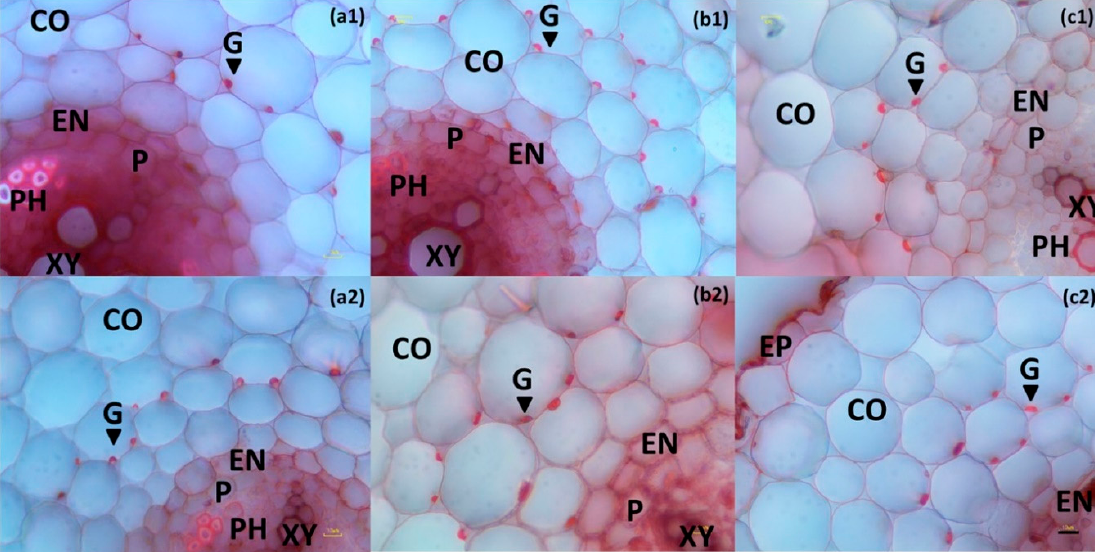
Figure 3. Freehand cross sections of first-order lateral roots under well-irrigated conditions ( a1 , b1 and c1 ) and drought stress conditions ( a2 , b2 and c2 ) at 21, 28 and 35 days after plant emergence (DAE). CO, cortex; EN, endodermis; G, phi-thickening or cell wall ingrowth; P, pericycle; PH, phloem; XY, xylem; Scale bar = 10 µ m; 40 ×.